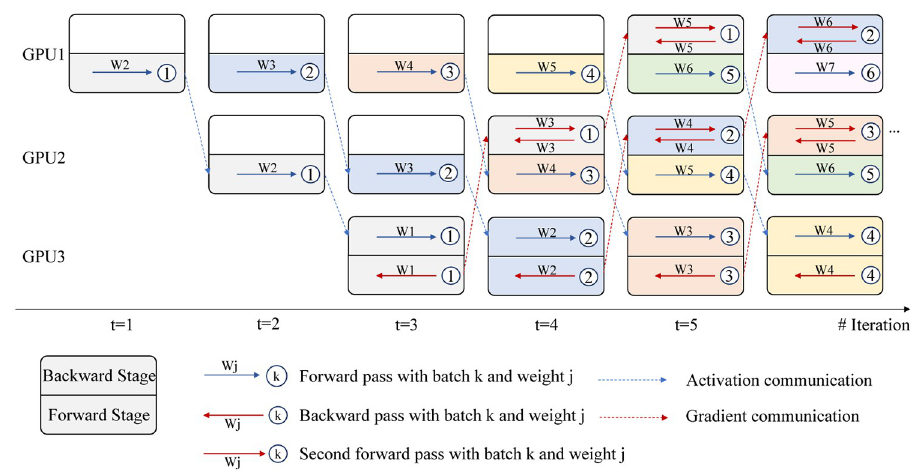
Fig 1. Illustration of Decoupled Training with Re-computation (DTR): A K = 3 example. Each color in the figure represents a completed forward and backward process in the whole model of a single batch.All modules execute backward stage (upper part) first and then forward stage (lower part) except the last module which processes reversely. In initial iterations where modules do not have backward stages, w t − k +2 is set to be equal to w t − k +1 (e.g. in module m 1 at iteration t = 1, W 2 = W